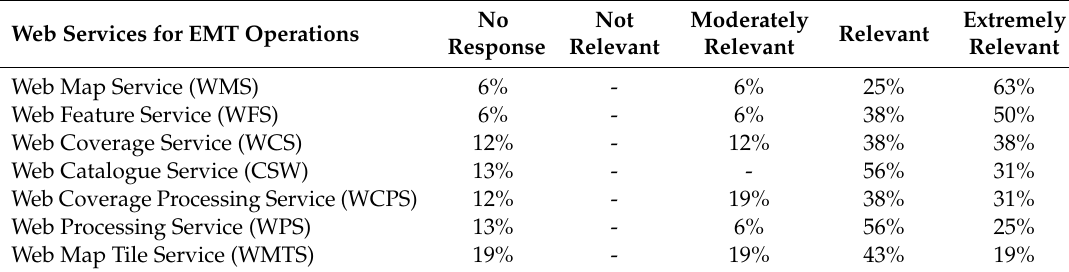
Table 8. Web services for emergency operations